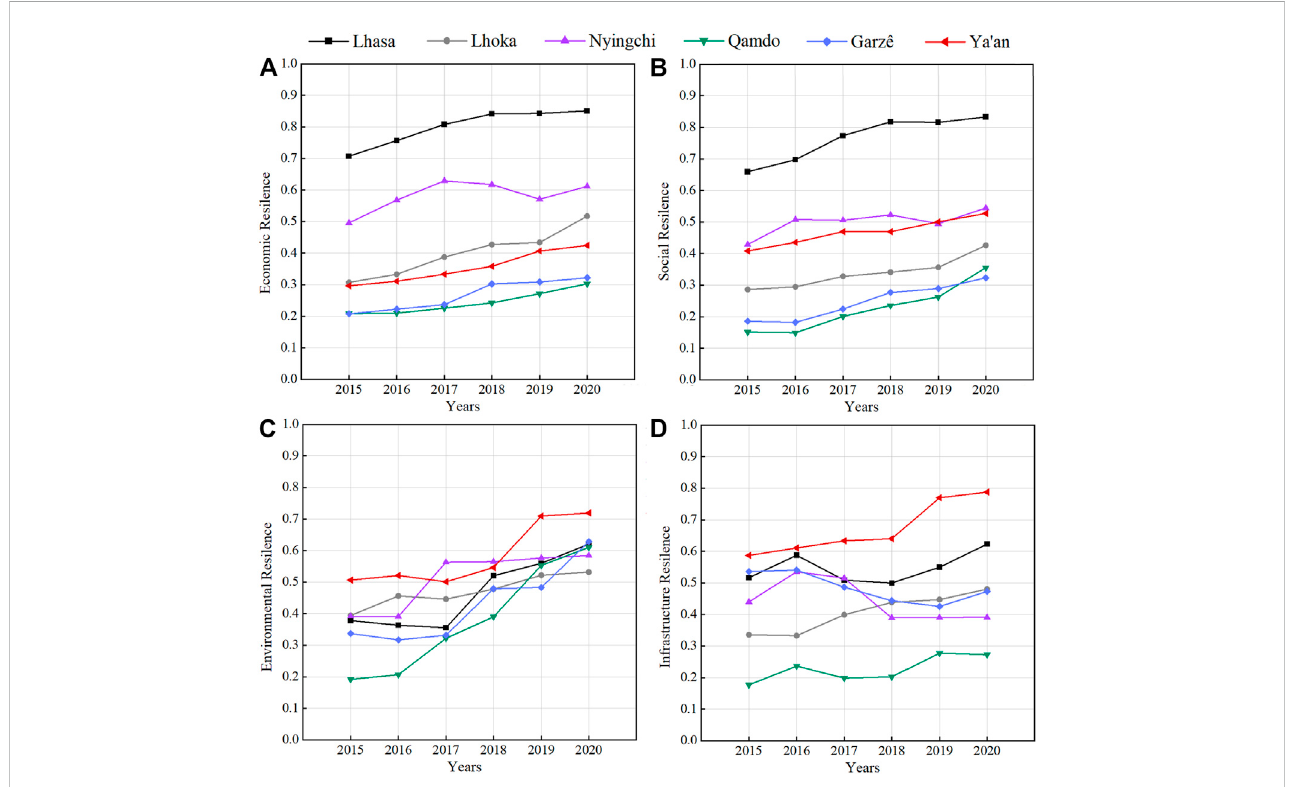
FIGURE 4 Trendsintheevolutionofvariousaspectsofresiliencelevels. (A) Economicresilience. (B) Socialresilience. (C) Environmentalresilience. (D) Infrastructure